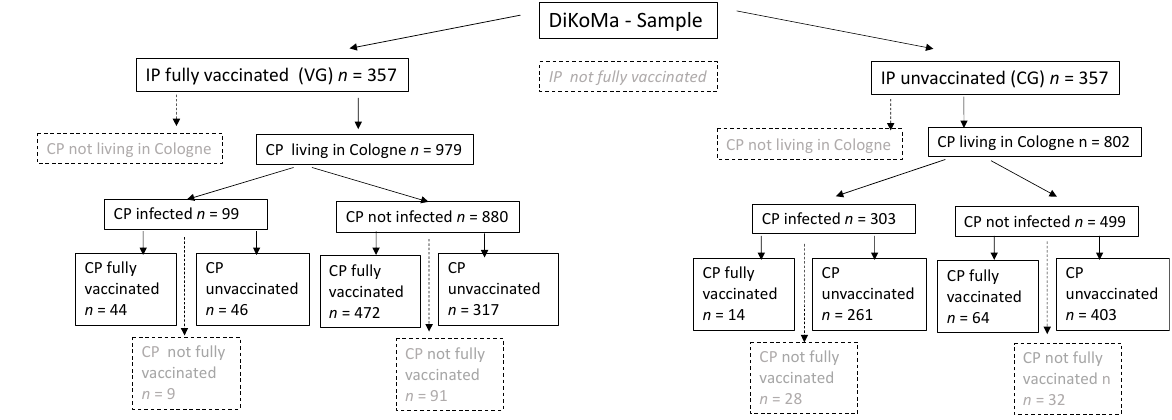
Figure 3. Flow chart of the study population; VG = vaccination group, CG = comparison group, CP = contact person; grey = data not